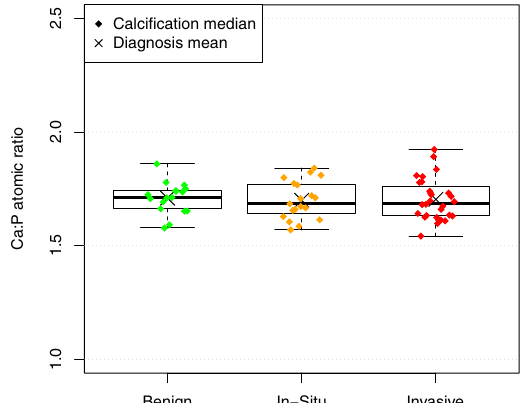
Figure 4. The Ca:P ratio of calcifications shows no systematic variation with specimen pathology.